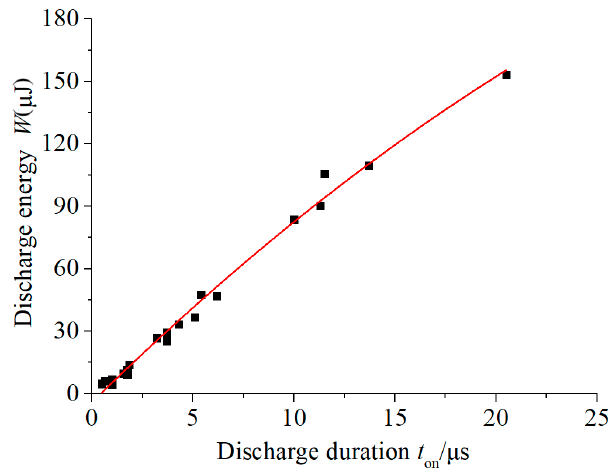
Figure 5. The e ff ect of the discharge duration on the discharge Figure 5. The effect of the discharge duration on the discharge energy.